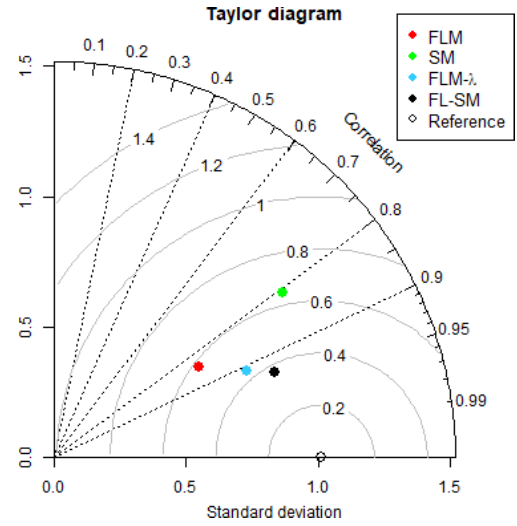
Figure 10. Results of the FLM for a cross-section area using dif- ferent intensities – I av (average), I 60 (60min), I 30 (30min) and I 15 (15min) – to generate the peak discharge.